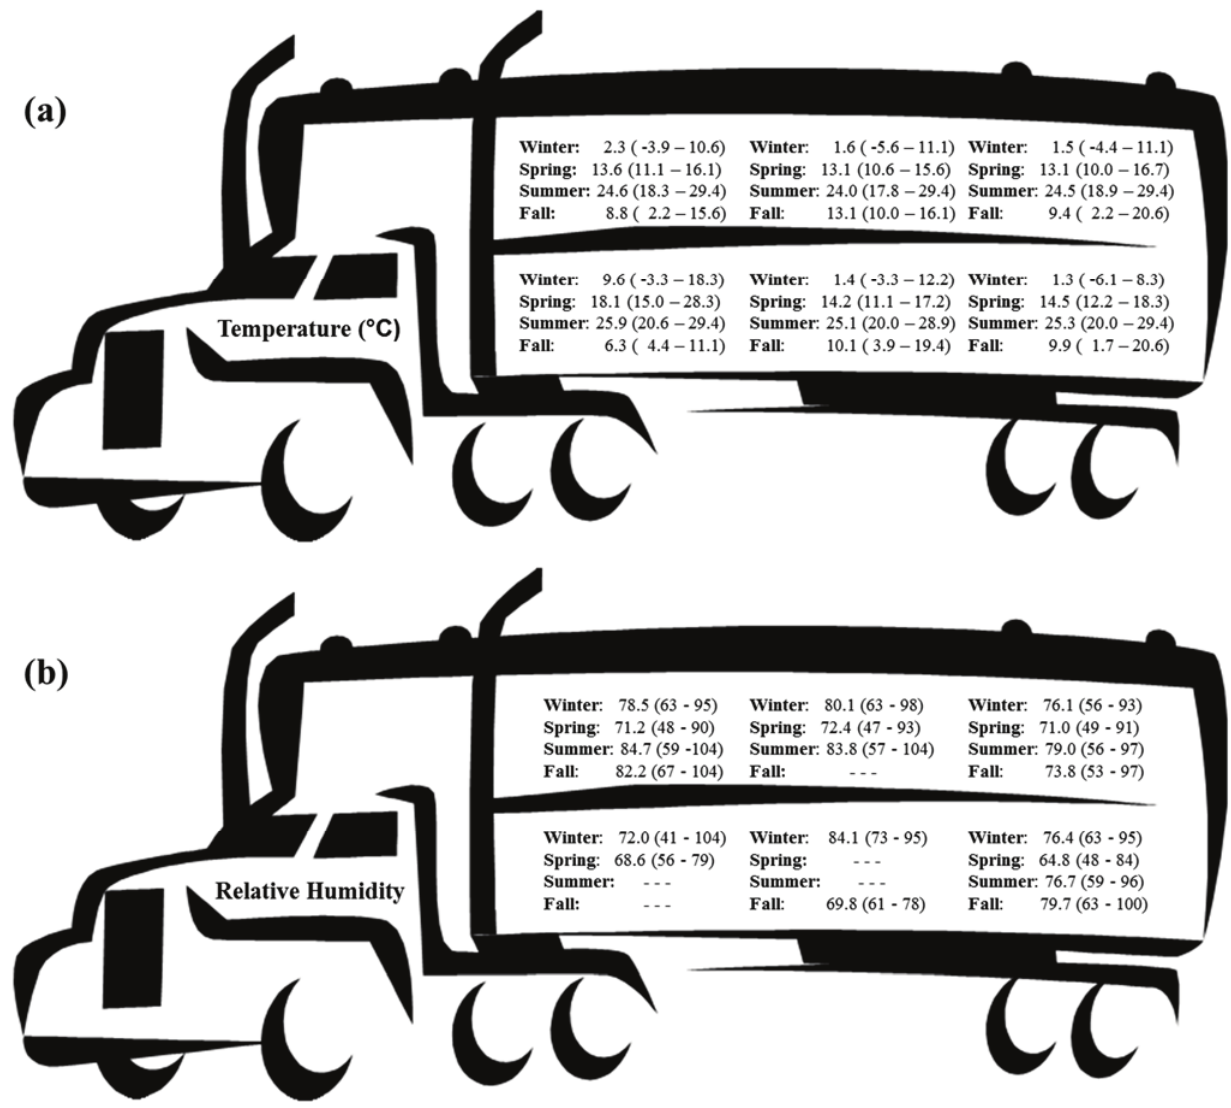
Figure 3. Averages and ranges of temperatures ( a ) and relative humidity ( b ) for each trailer compartment for each season of the 6 h transport